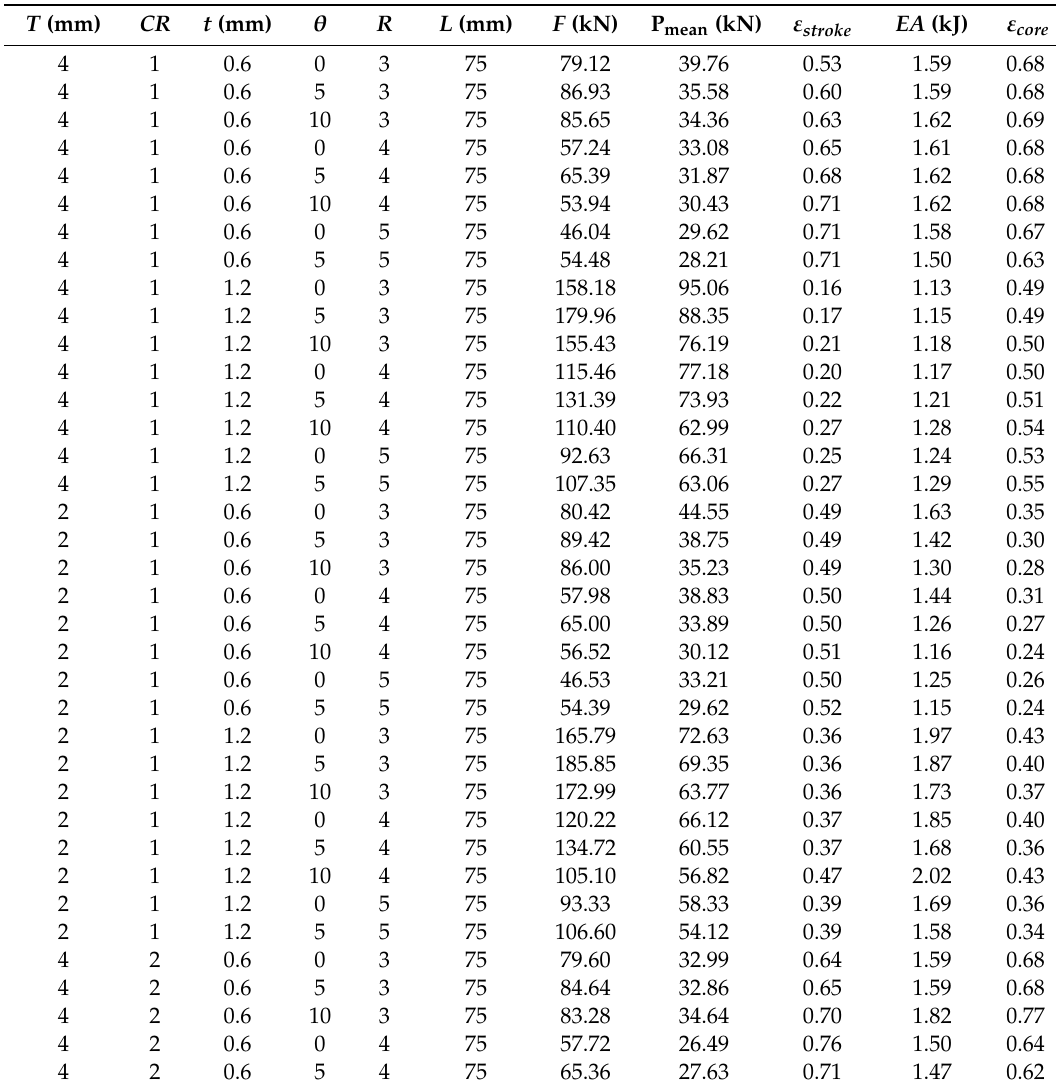
Table A1. Performance indicators